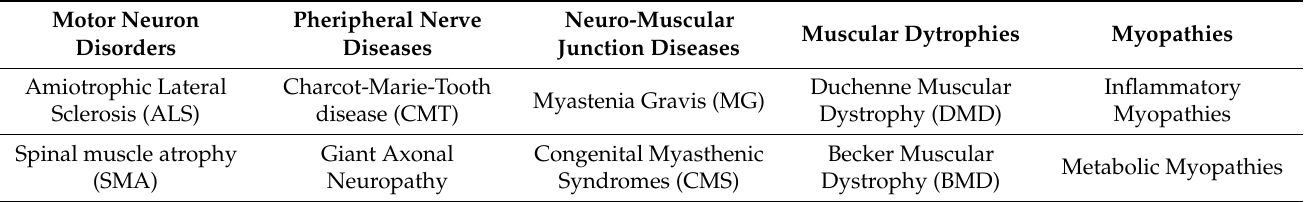
Table 1. Classification of neuro-muscular